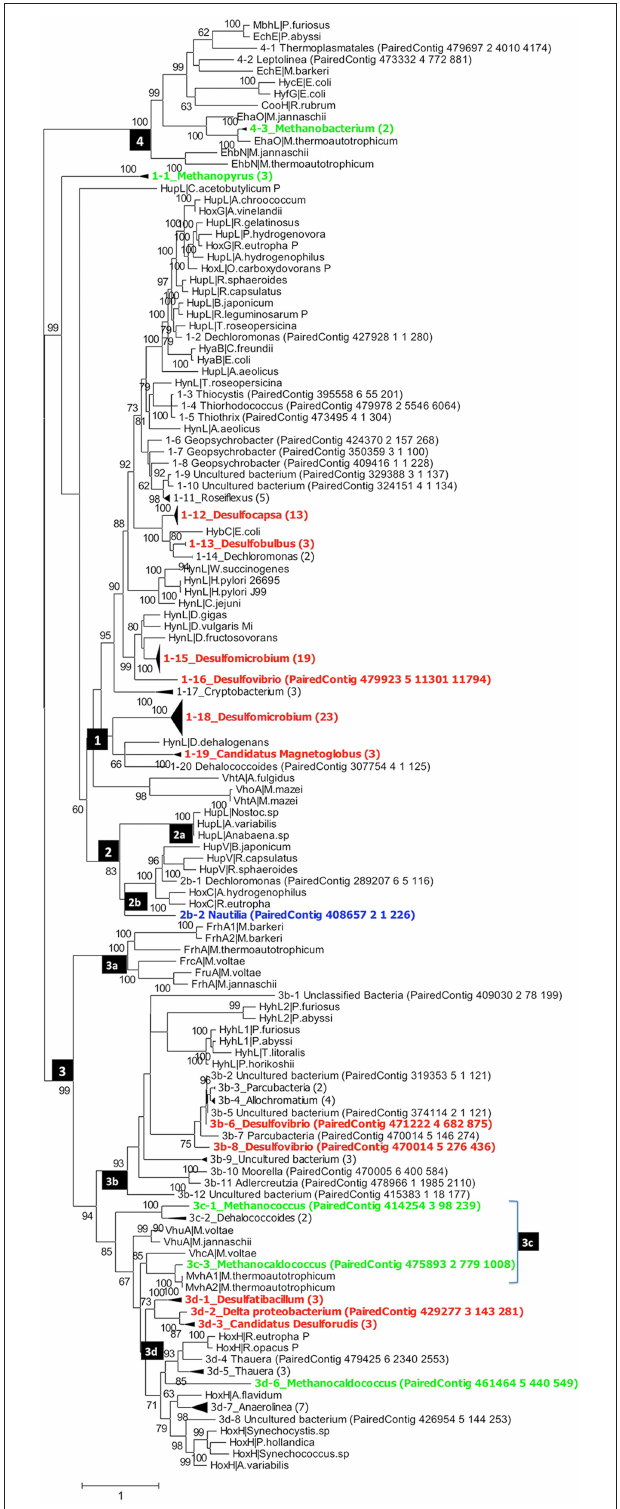
FIGURE 2 | Phylogenetic analysis of putative hynL genes for the large subunit of [NiFe]-hydrogenase detected in the PAS-616P metagenome. Contigs with high similarity and the same taxonomic origin were collapsed into, and